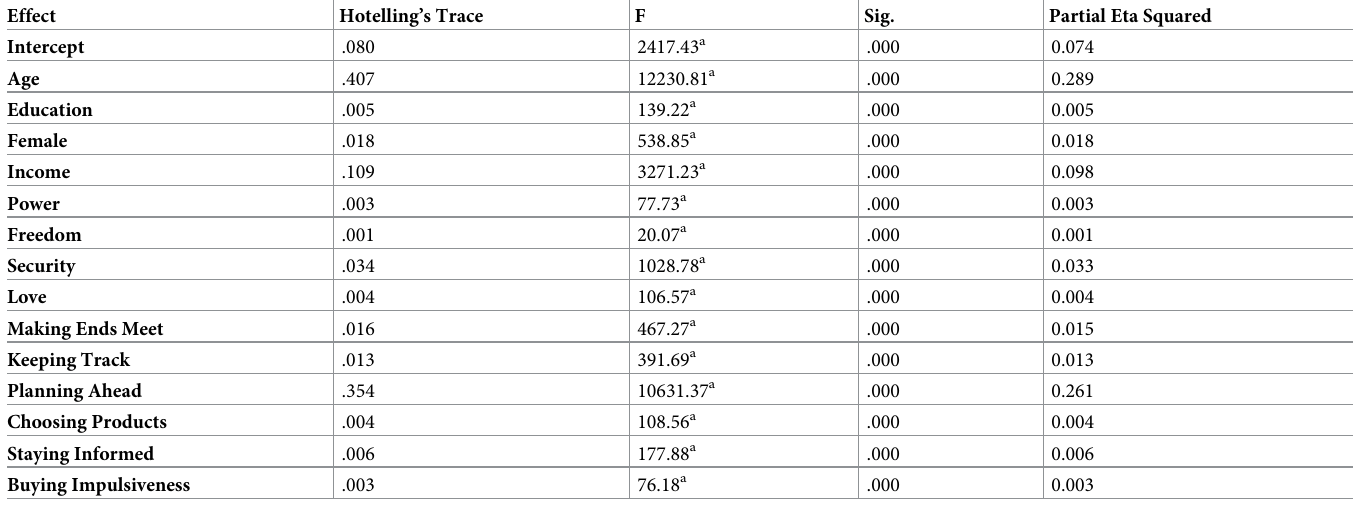
Table 2. Multivariate tests of multivariate multiple regression with three wealth measures.